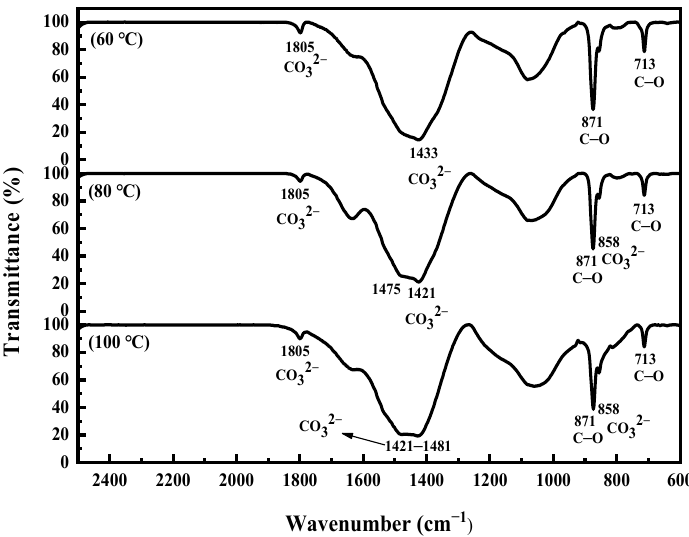
Figure 7. Characteristic infrared vibration peaks were detected at 713 cm − 1 , 871 cm − 1 , 1421– 1481 cm − 1, and 1805 cm − 1 in carbonated AOD slags [19] corresponding to the C-O stretching vibration peak, C-O anti-symmetric stretching vibration peak, CO 32 − out-of-plane deformation vibration peak, and CO 32 − in-plane deformation vibration peak of CaCO 3(C) , it showed that calcite (CaCO 3(C) ) was formed in the carbonated AOD slag at different temperatures. It was worth noting that the carbonated AOD slag still had a characteristic infrared vibration peak at 858 cm − 1 at 80 ◦ C and 100 ◦ C, corresponding to the CO 32 − out-of-plane bending vibration in aragonite (CaCO 3(A) ). It showed that aragonite (CaCO 3(A) ) was precipitated in the carbonated AOD slag, which was consistent with the analysis results of the above XRD analysis.